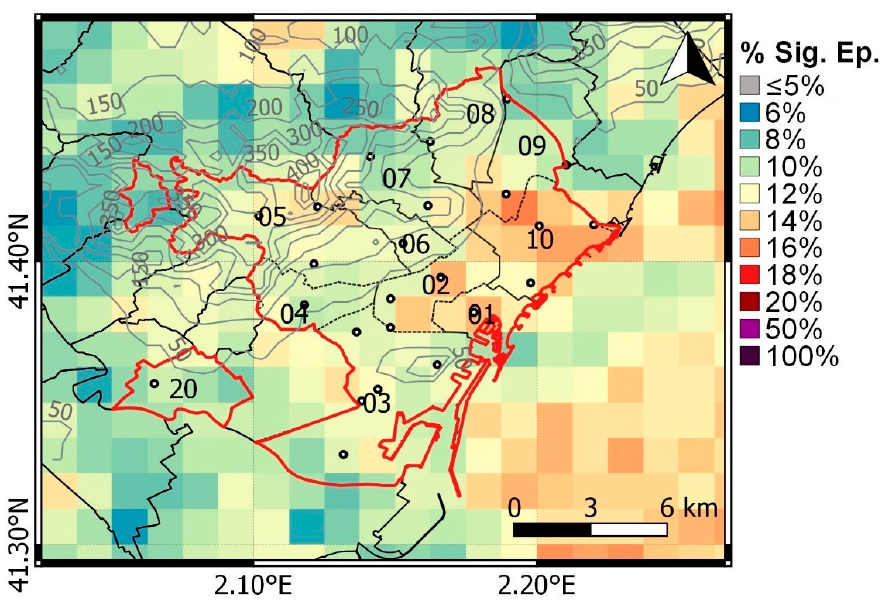
Figure 7. Same as Figure 6, for 45 dBZ.